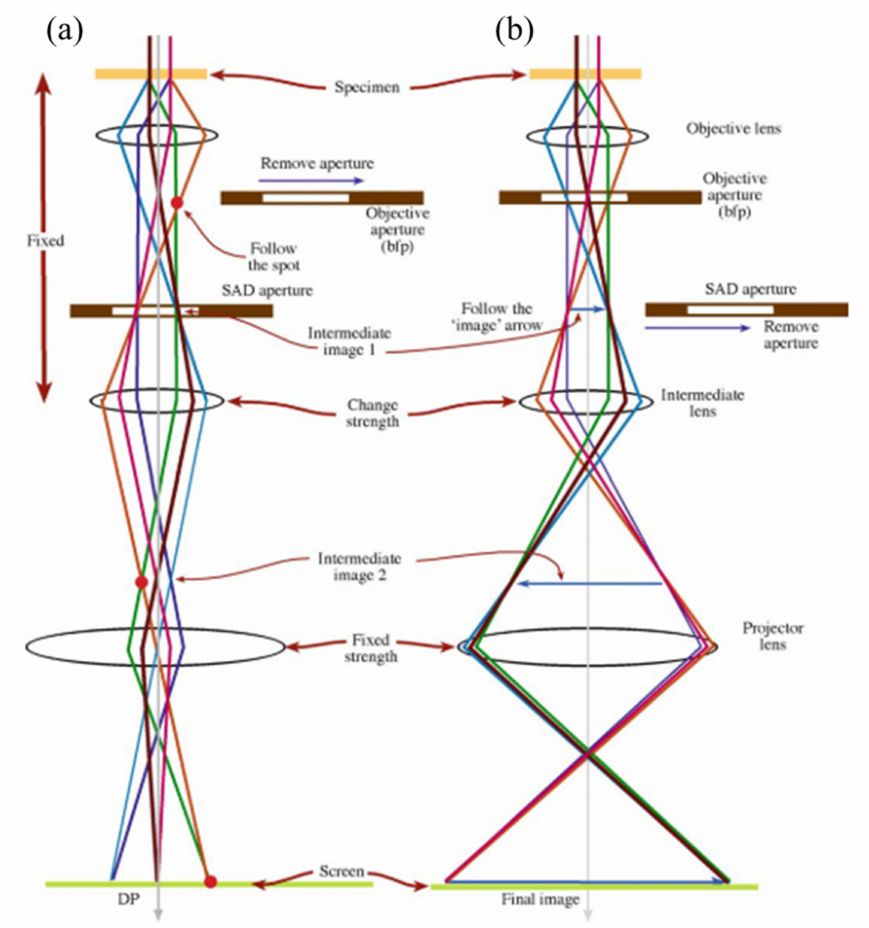
Figure 7. Ray diagrams demonstrating two basic operation modes in a conventional TEM. In ( a ) diffraction mode, the DP is projected onto the viewing screen and ( b ) image mode, projecting the image onto the screen [92]. Switching between the modes requires changing the strength of the intermediate lens. Figure 7 reprinted by permission from Springer Nature Customer Service Centre GmbH: Springer Nature, Springer eBook, Diffraction in TEM, David B. Williams, C. Barry Carter, Copyright © 2009, Springer Science Business Media New